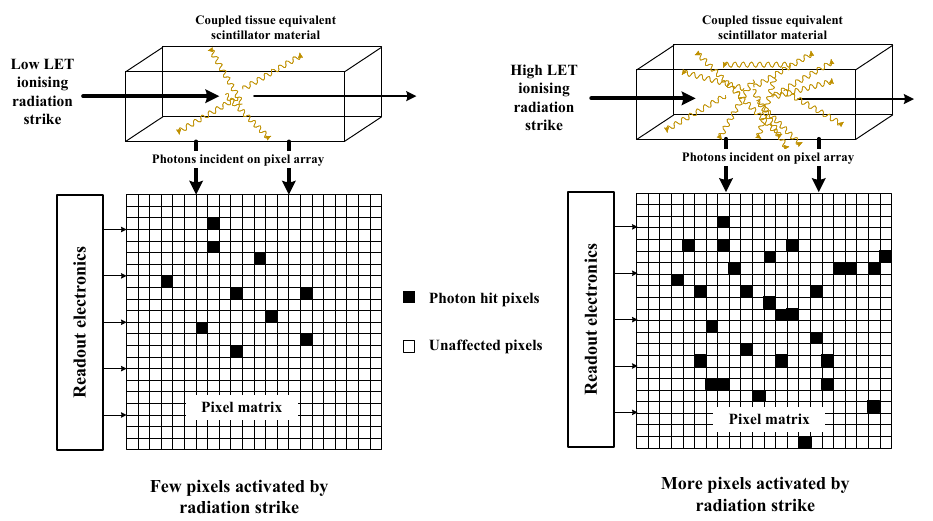
Figure 4. Illustration of working principle of scintillator coupled solid-state photomultiplier (SSPM) based